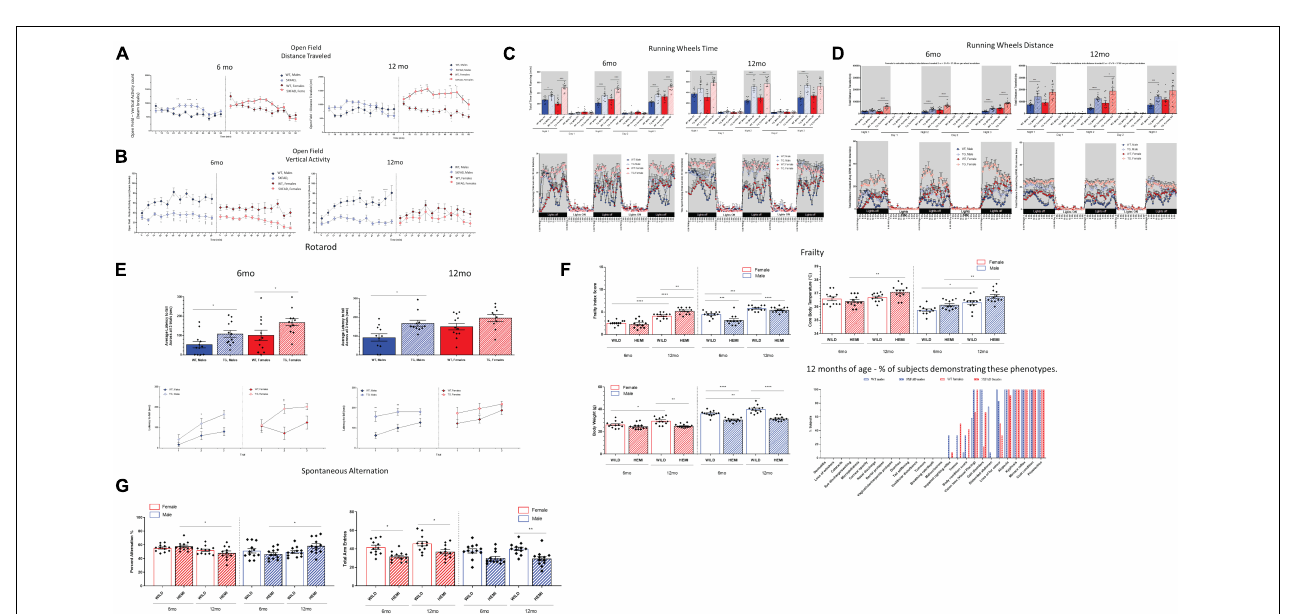
FIGURE 1 | Decreased total cholesterol and lipoproteins in 5XFAD males compared to wild-type males and decreased glucose levels in 5XFAD females compared to wild-type females. Non-fasted plasma was collected at the termination of the study, and total cholesterol (A) , low-density lipoproteins (B) , high-density lipoproteins (C) , triglycerides (D) , non-essential fatty acids (E) , and glucose (F) levels were measured.